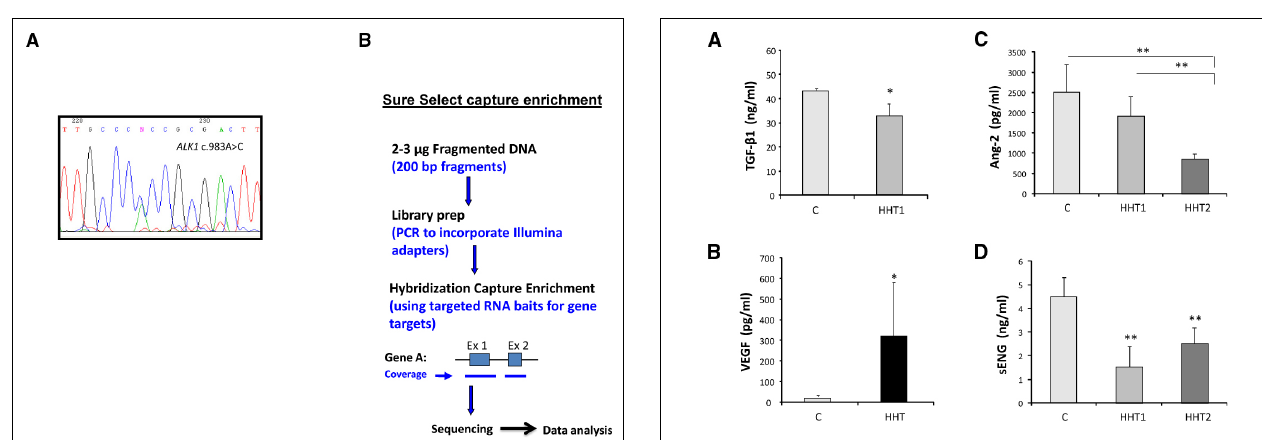
FIGURE 2 | Sanger sequencing vs next generation sequencing (NGS). (A) Typical chromatogram showing the results of Sanger sequencing. (B) Sequencing scheme following capture enrichment of gene targets in a panel of diagnosis. NGS involves three major components: sample preparation, sequencing, and data analysis. The process begins with extraction of genomic DNA from a patient sample. Library generation is the process of creating random DNA fragments, of a certain size range, here represented by 200-bp, that contain adapter sequences on both ends. This library is the required input for most currently available NGS platforms. The adapters are complementary to platform specific PCR and sequencing primers. Target enrichment is achieved by RNA bait hybridization with the specific genes of interest. Adapted from Wooderchak-Donahue et al. (2012).